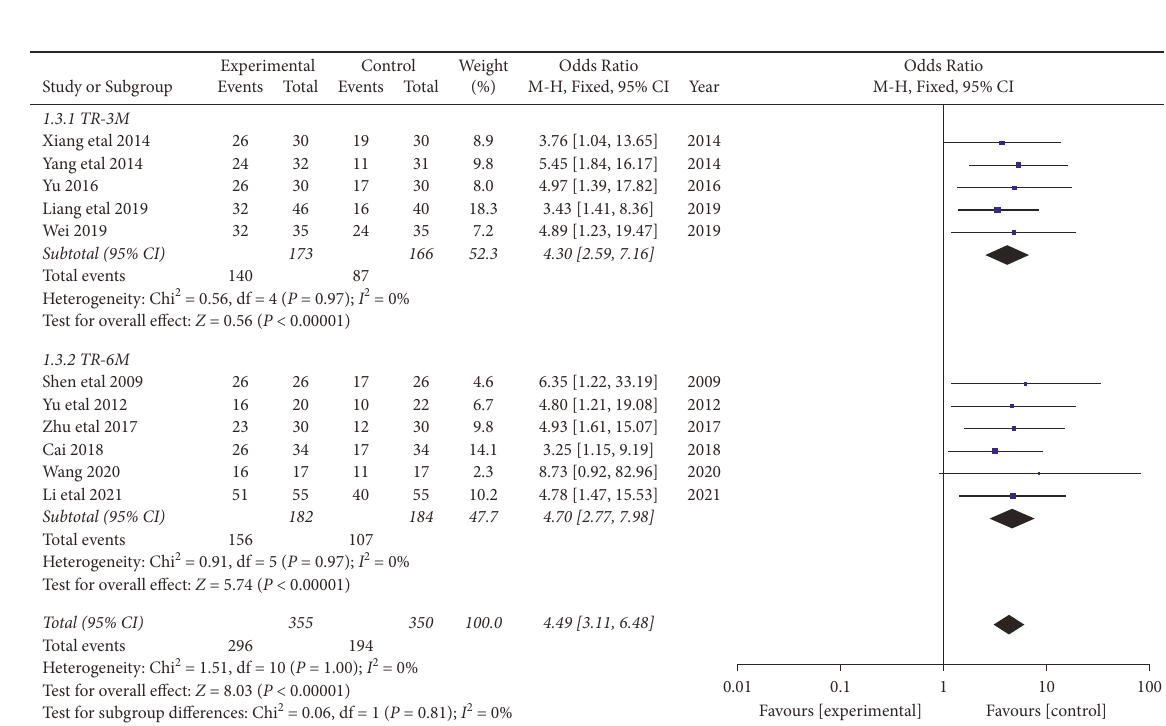
Figure 4: Comparison of GTW combined with RASI versus RASI TR-3 months versus 6